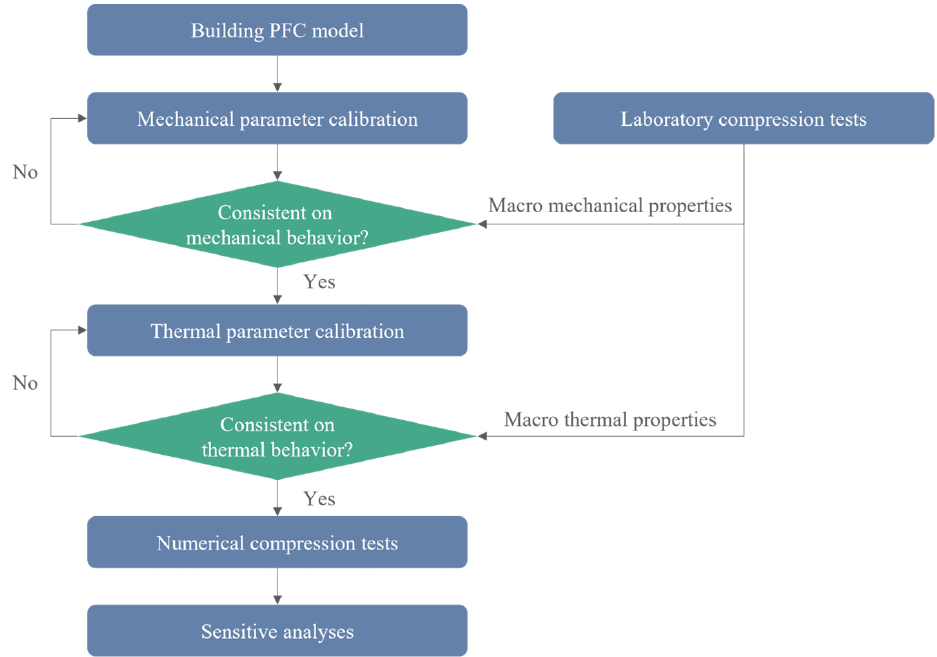
Figure 4. Flowchart for the work process.